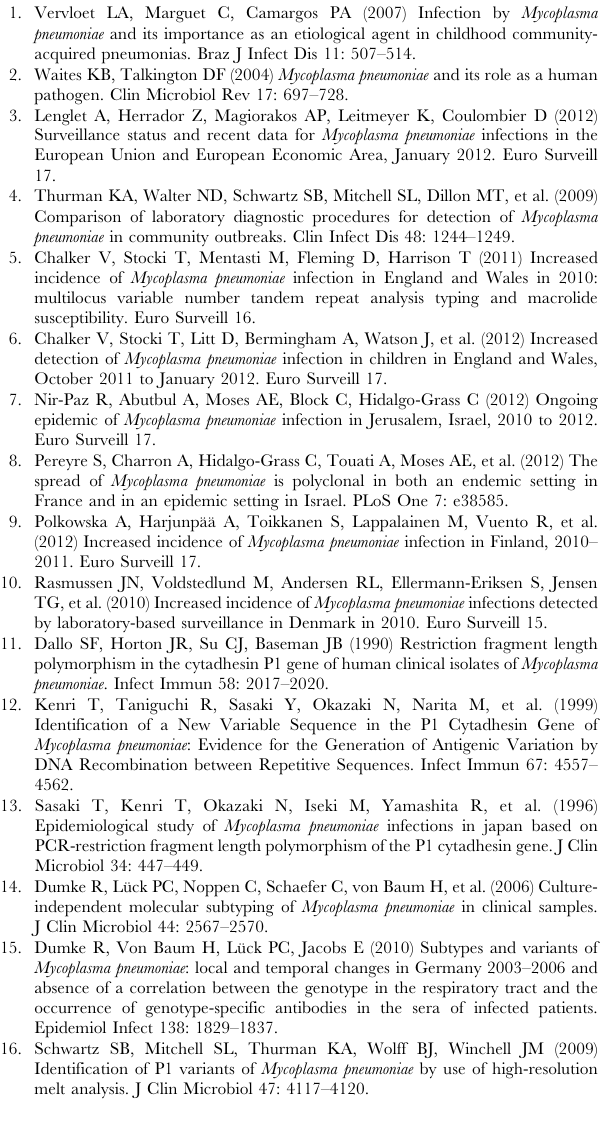
Figure S1 Different VNTR copy numbers of Mpn1 counted from the sequence